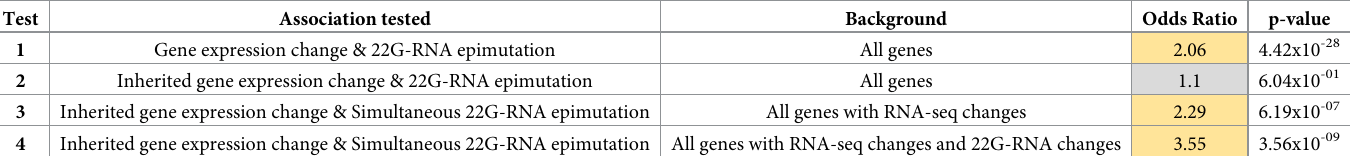
Table 2. Stepwise analysis of association of gene expression changes and 22G-RNA-based epimutations. Cells in grey indicate no significant association, cells in yellow indicate significantly increased odds of association. Odds ratios and p-values calculated with Fisher’s Exact Test.